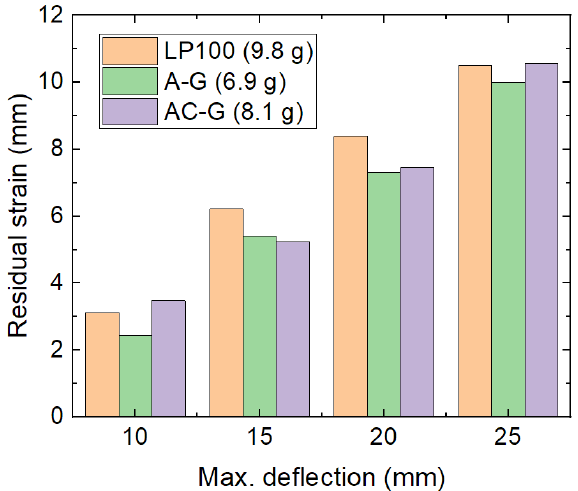
Figure 6. Comparison between the best lightweight samples of the recent study with the best (heavier) sample of the previous study [18] in terms of the residual strain.